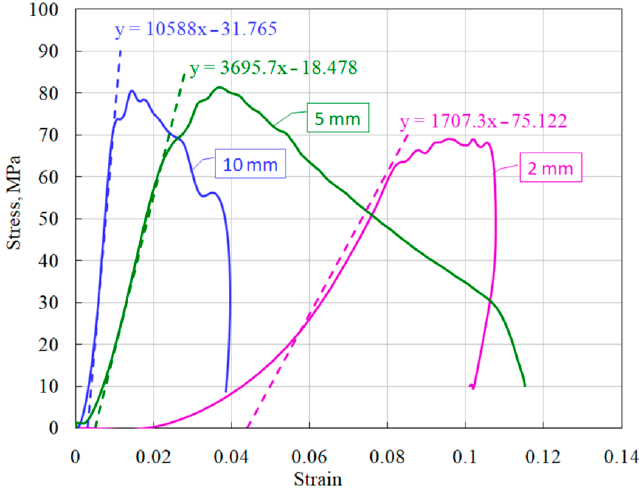
Figure 11. Definition of modules of load branches of ceramic diagrams for specimens of different lengths.